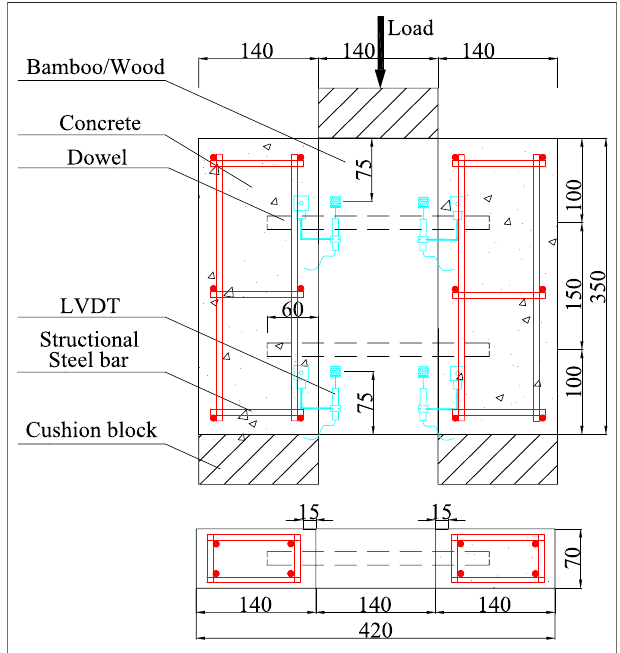
FIGURE 4 | Test setup of bamboo/wood-concrete connections.